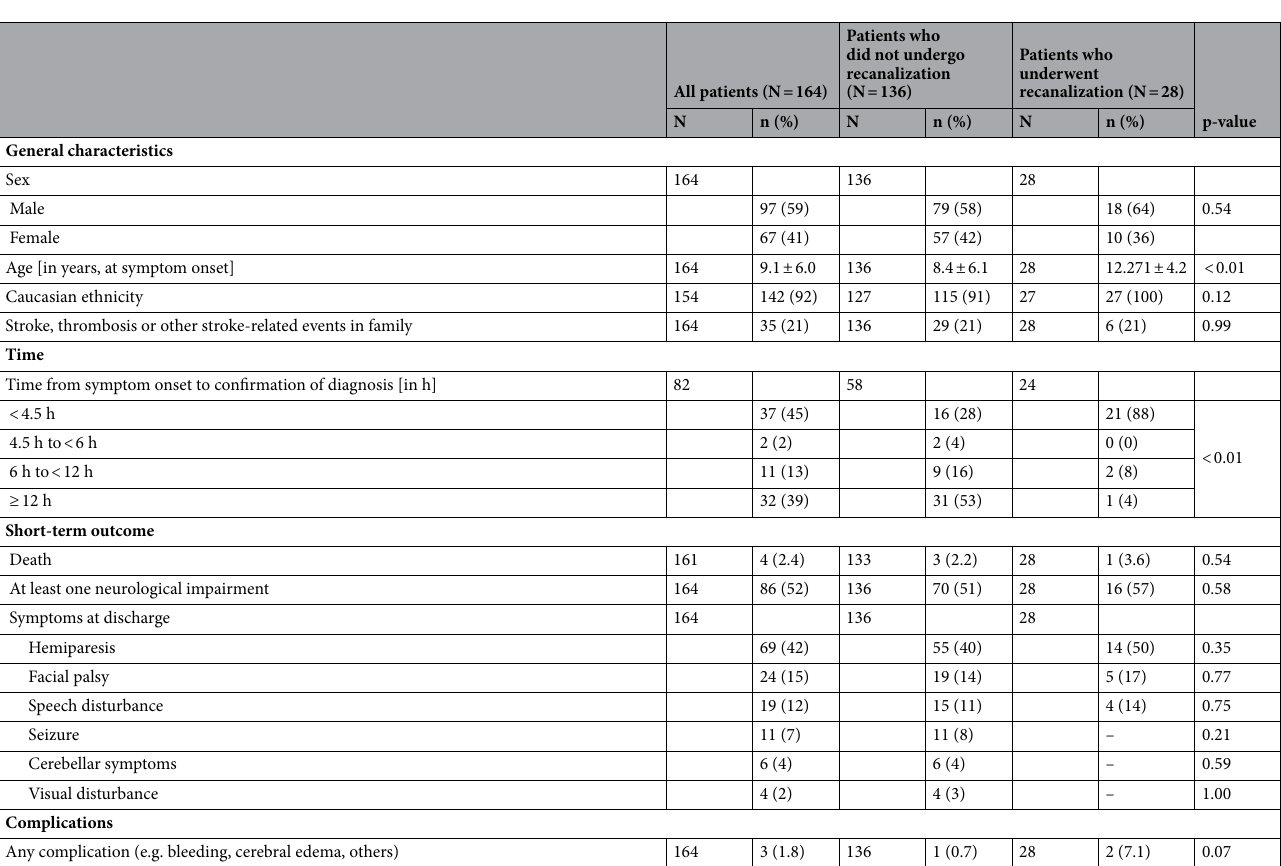
Table 1. Patient characteristics. Patient characteristics for the whole group (n = 164) and the subgroups of patients that did not (n = 136) and did undergo recanalization therapy (n = 28). Quantitative variables are expressed as mean ± standard deviation. Categorical variables are expressed as n (%). Test for differences between patients with recanalization vs. patients without recanalization: p-values are obtained from chi-square or fisher exact tests for categorical data and from Wilcoxon rank sum test for continuous